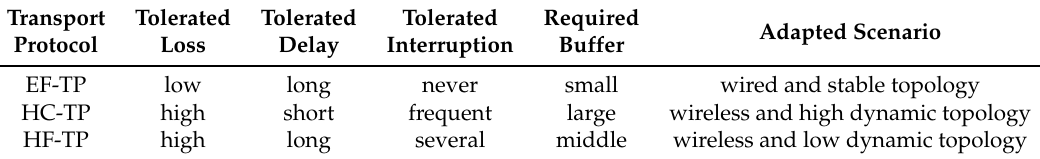
Table 1. Scenario example on the adaptive decision-making among three implemented